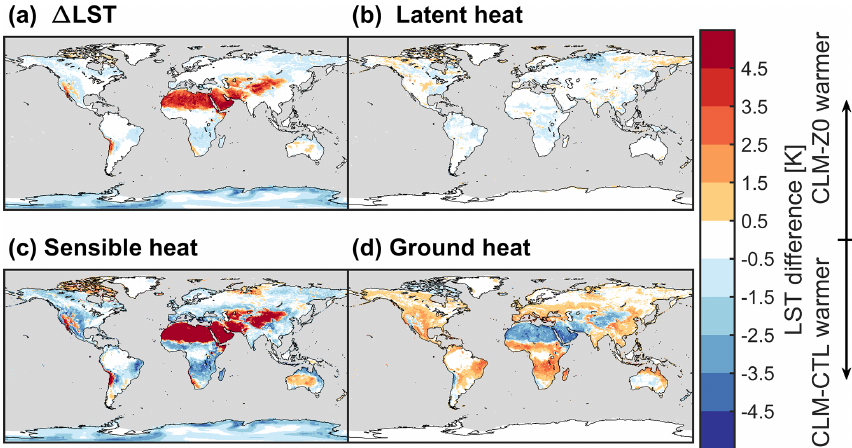
Figure A2. Energy balance decomposition for change in LST at 13:30 local solar time in boreal summer of CLM-Z0 minus CLM-CTL. (a) Change in LST, (b) contribution from change in latent heat, (c) contribution from change in sensible heat, and (d) contribution from change in ground heat flux. Note that some terms are not shown because they are zero in offline simulations (incoming radiation terms) or because they are small (albedo and the imbalance